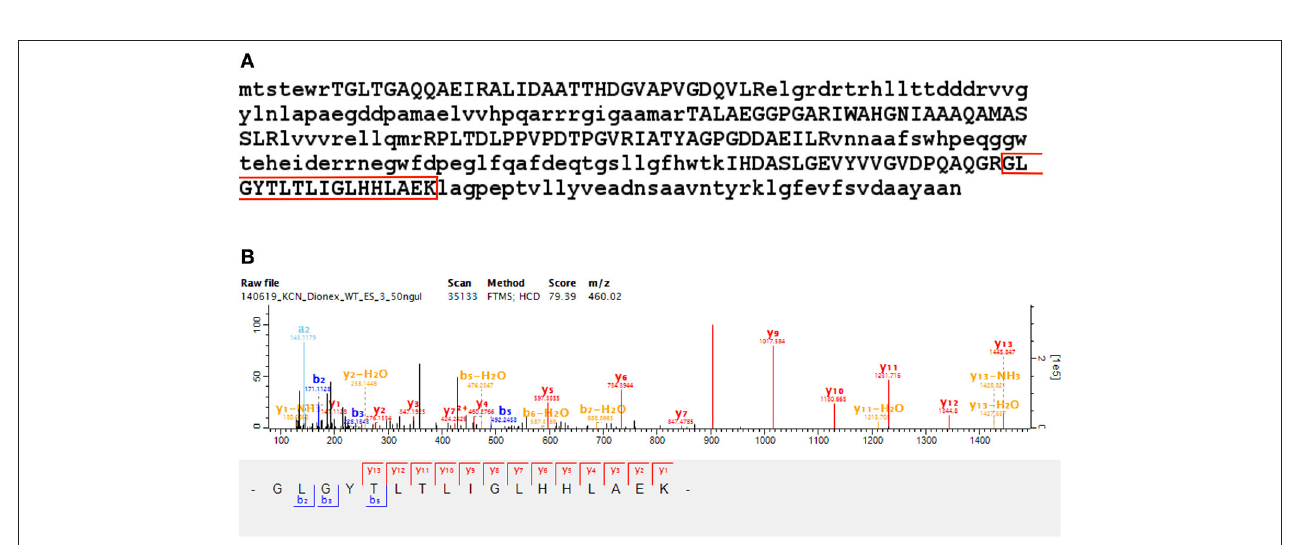
FIGURE 4 | Reference protein frameshift validation — MSHD . Shows the identification of A4ZHT6 (Mycothiol acetyltransferase), a Reference protein inferred from homology. (A) This sequence corresponds to an interrupted coding sequence (ICDS) identified by Deshayes et al. (2007), which they confirmed by resequencing to span a sequencing error in the M. smegmatis mc 2 155 genome (GenBank accession DQ866865). We present peptide evidence for this protein with eight peptides identified from 50 MS/MS scans after searching the Reference proteome database, as well as identifying a peptide spanning the frameshift position (245) in the corrected sequence—highlighted in red. (B) A representative spectrum of the highlighted peptide, which was identified with four MS/MS scans, supporting the sequence correction at the peptide level.